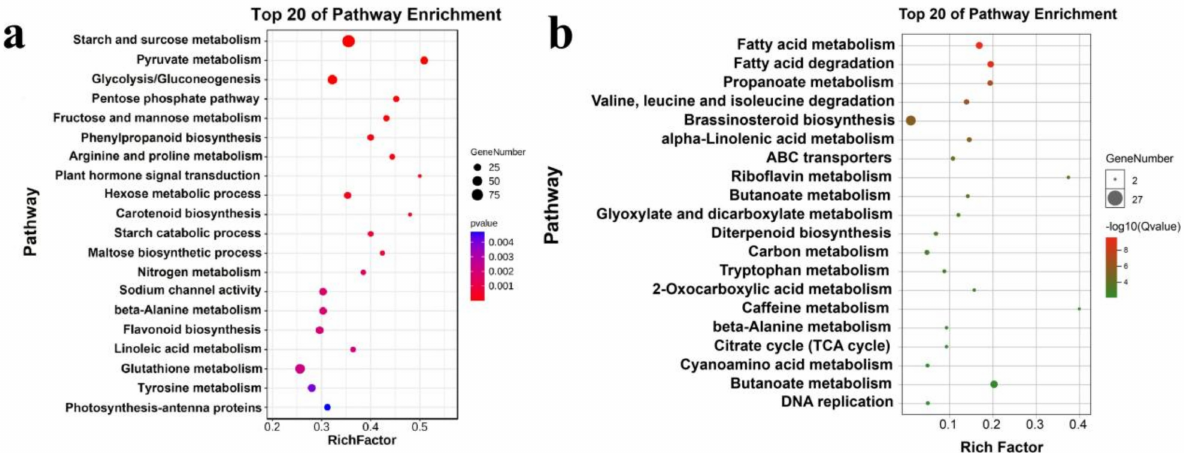
Figure 2. Analysis of KEGG Enrichment of differentially expressed genes in purple sweetpotato under salinity. ( a ) The top 20 of pathway enrichment based on biological process and ( b ) based on molecular